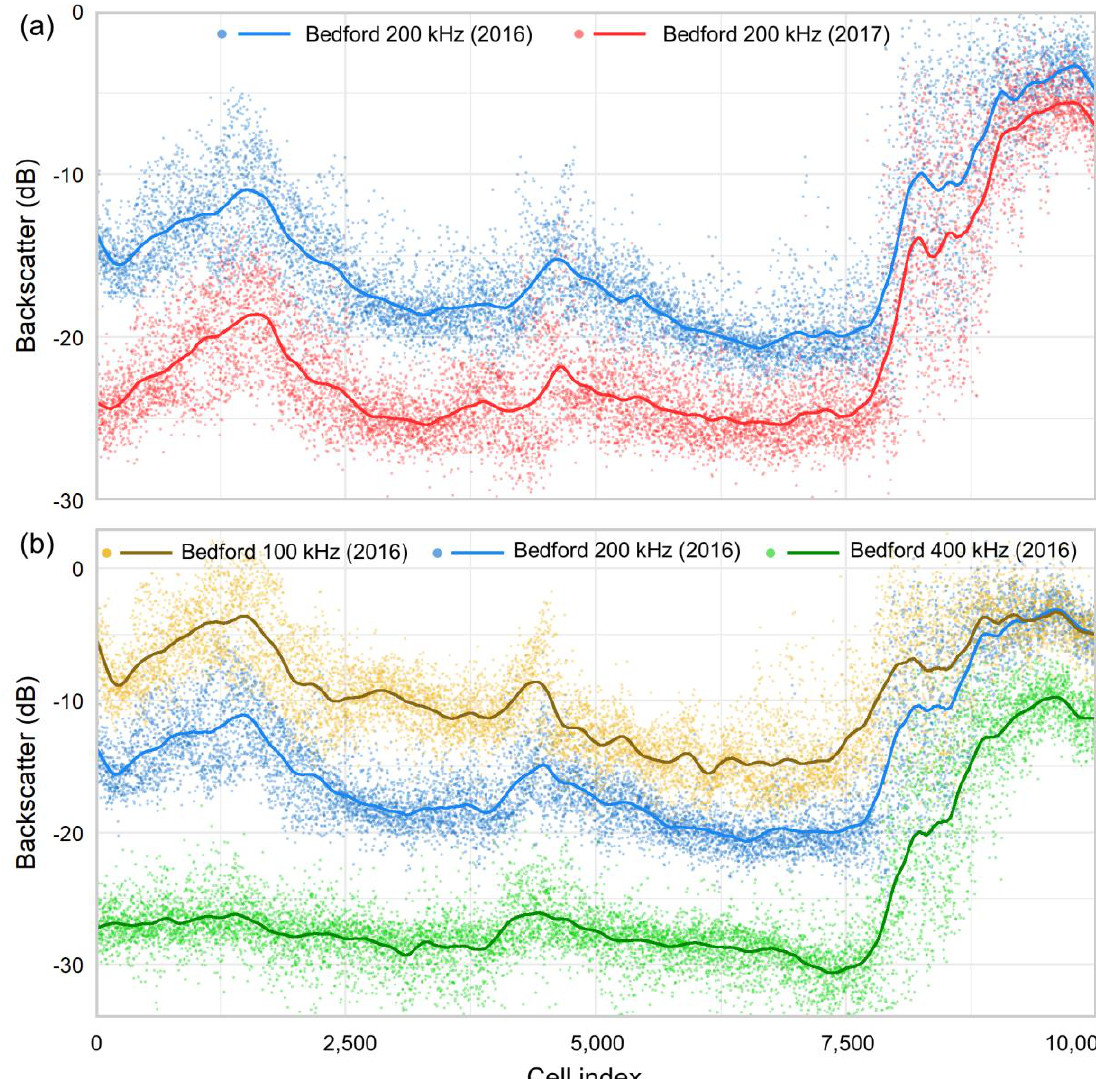
Figure 4. ( a ) 200 kHz backscatter data from Bedford Basin in 2016 and 2017 from simulated area of overlap. ( b ) Multispectral backscatter from Bedford Basin in 2016 from simulated area of overlap. X-axes are ordered by cell index, in which the rasters are read; roughly north to south. Dark lines are first order polynomial LOESS curves fit with span of 0.03. Table 2. Summary of bulk shift simulations.